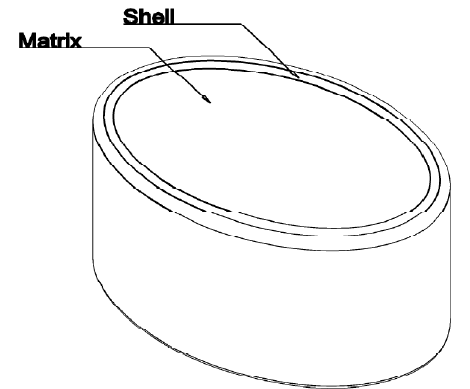
Figure 1. Egalet® ADPREM